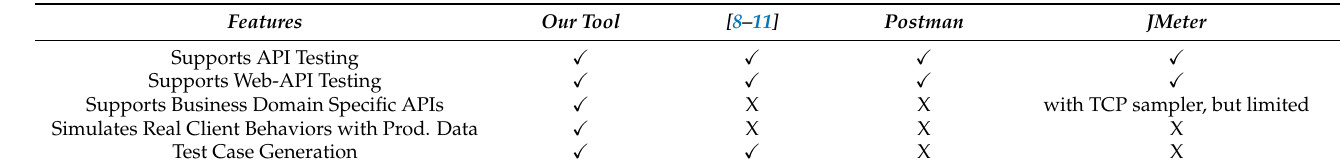
Table 1. Comparison with other tools/studies that perform the provided features.